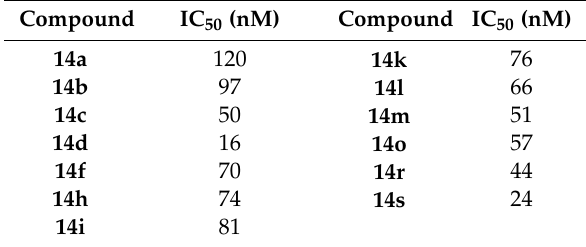
Figure 2. Antiproliferative activity of the bis-benzamide library 14 at 200 nM on LNCaP cells by MTT assay. Table 2. Antiproliferative activity of bis-benzamides 14 a .